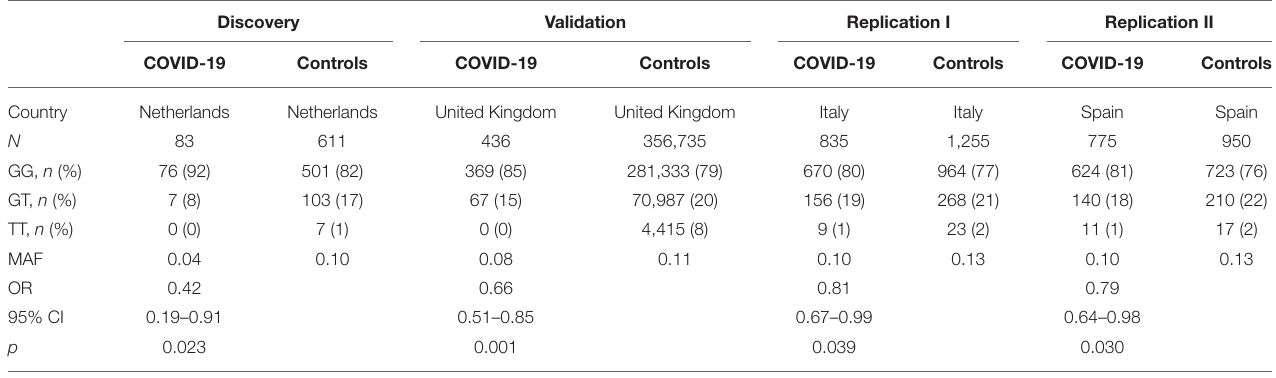
TABLE 3 | MUC5B rs35705950 genotype in white subjects with severe COVID-19 and controls.